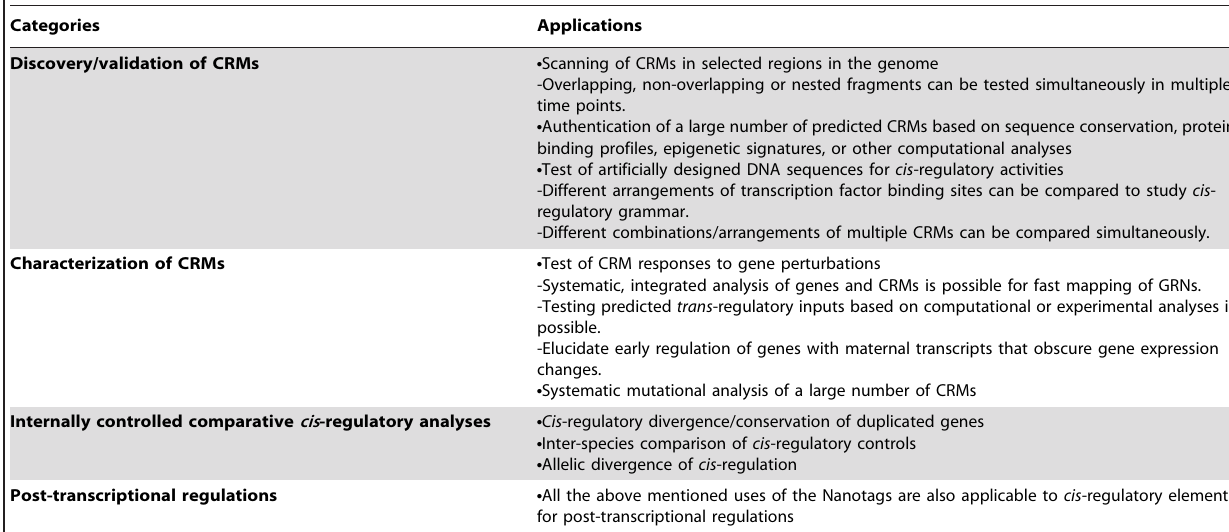
Table 2. Possible uses of the Nanotag